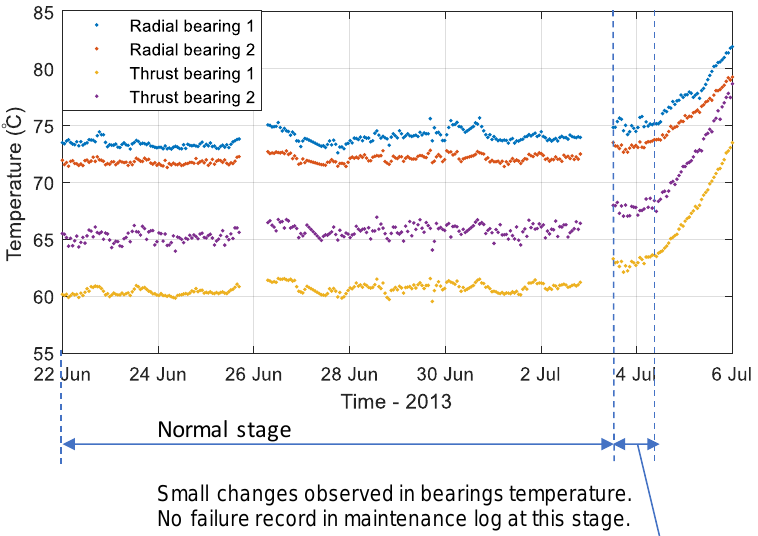
Figure 13. The measured bearing temperature obtained from the pump’s condition monitoring system.